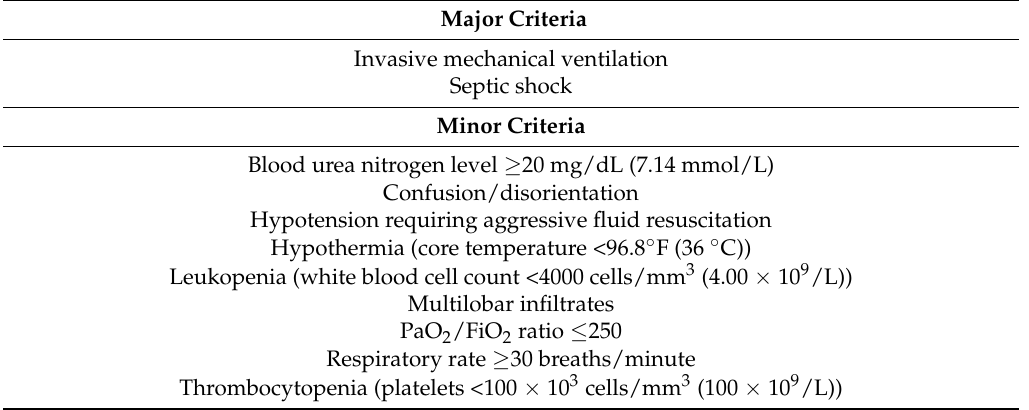
Table 1. The ATS/IDSA severity criteria for community-acquired pneumonia. Adapted from reference